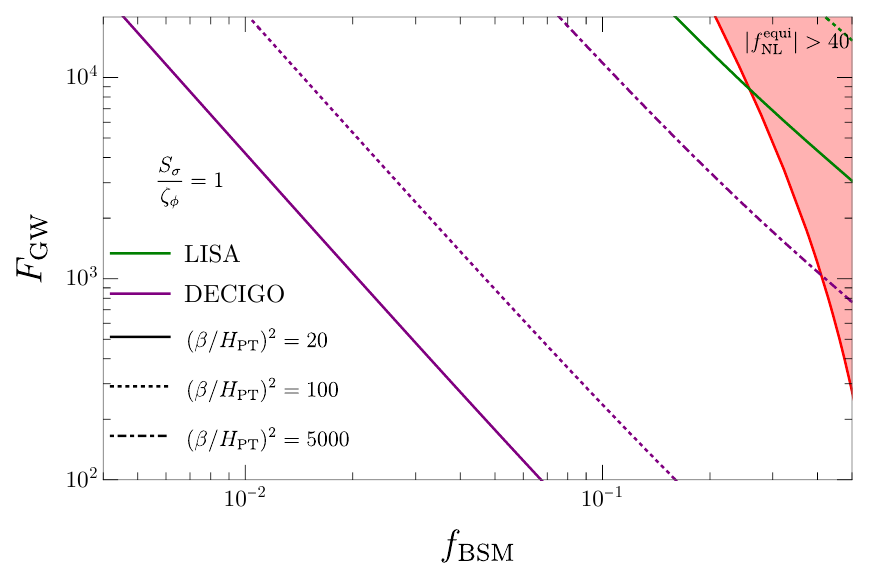
Figure 2 . The projected sensitivity of the Gravitational Wave Background NG, F GW as a function of energy fraction f BSM of the BSM sector undergoing PT for the case of equilateral NG. In our context the PT parameter α = f BSM . Depending on different assumptions of the PT parameter ( β/H PT ) , LISA and DECIGO would be able to probe regions above the green and purple lines respectively. The reach of BBO, which we do not show explicitly for clarity, is expected to be slightly better than that of DECIGO. The region labeled | f equi | > 40 is ruled out based on the NL constraints on equilateral NG from Planck